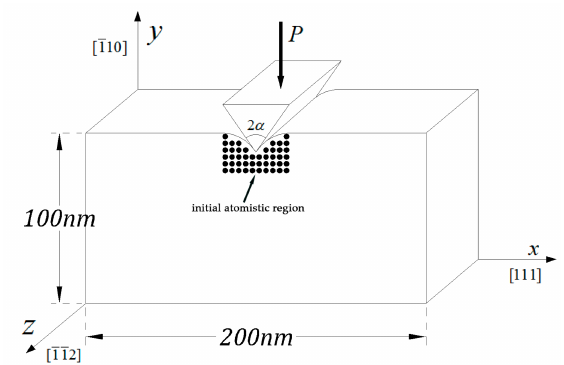
Figure 1. Schematic representation of wedged